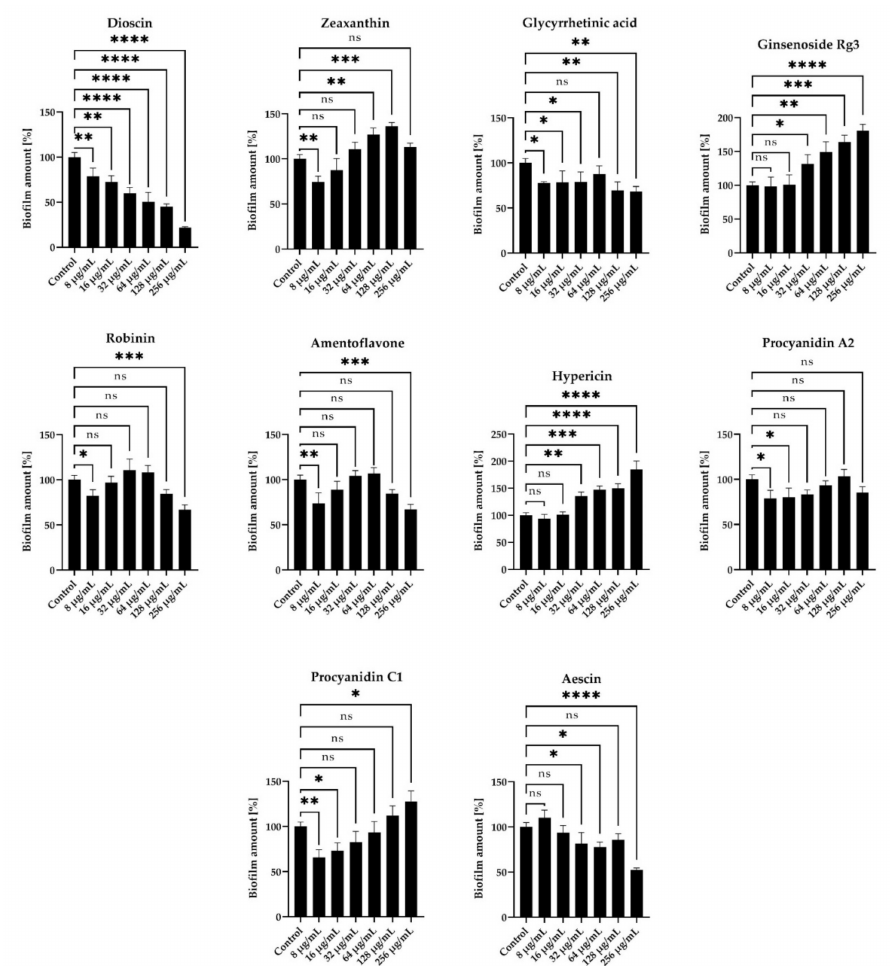
Figure 3. Anti-biofilm activity of 10 selected compounds of natural origin against H. pylori J99. The amount of biofilm under stationary conditions was determined using the crystal violet staining method. The study was performed with triplicate biological replications ( n = 3). The p -value represented by ns, *, **, ***, and **** is equal to > 0.05, < 0.05, < 0.01, < 0.001, and < 0.0001,